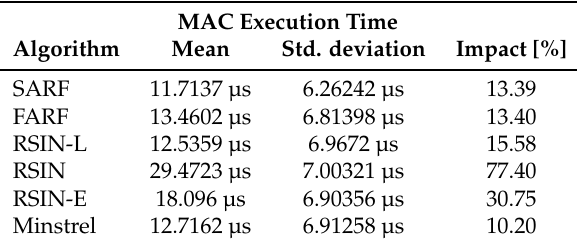
Figure 5. ECDFs representing the IEEE 802.11 MAC layer execution times. Table 4. Impact of the RA techniques on the MAC layer execution